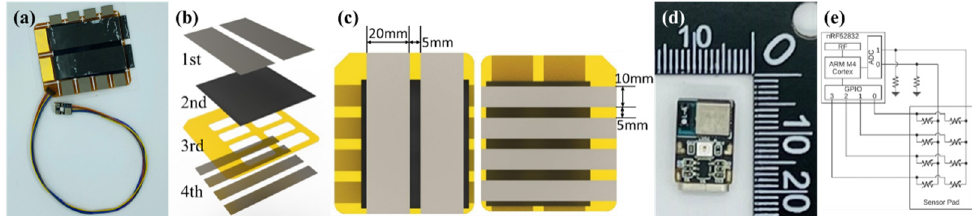
Figure 2. Mode-switchable touch sensor: ( a ) whole image ( b ) sensing pad layer composition, ( c ) dimensions, ( d ) main circuit, and ( e ) schematic of the driving circuit.